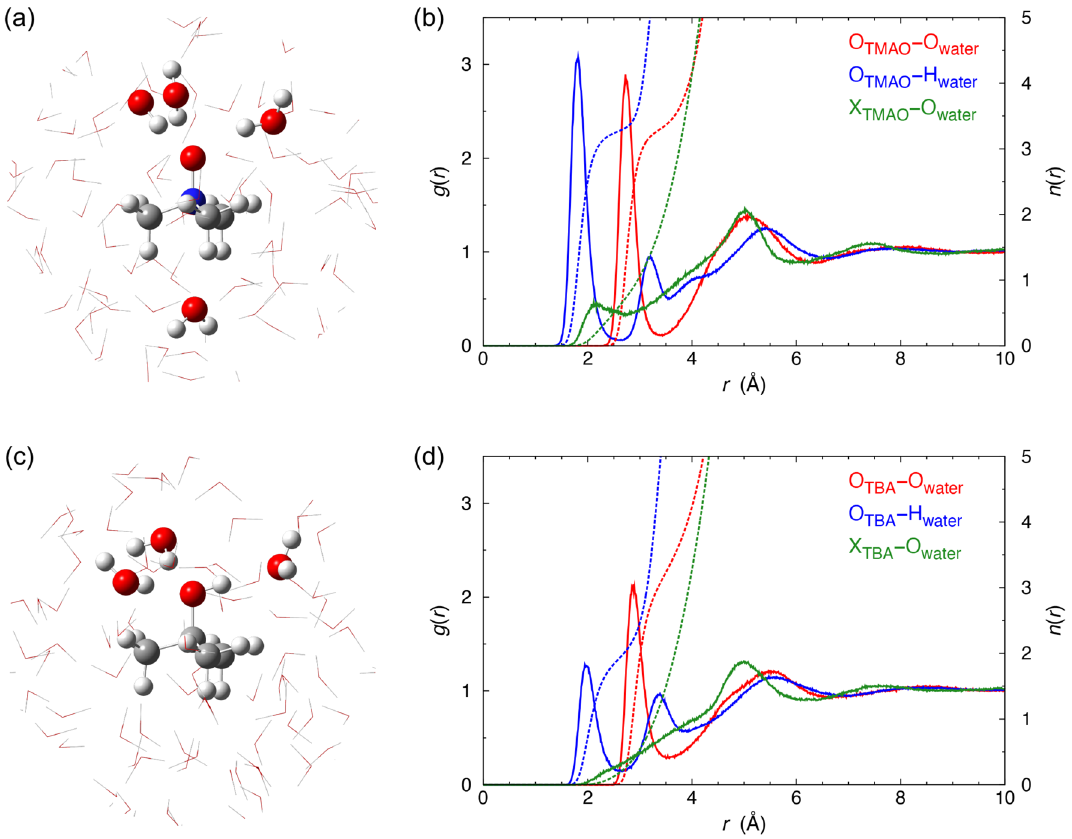
Figure 1. Solution structures simulated by EFP-MD. ( a ) Snapshot of aqueous TMAO. ( b ) Solute–solvent site RDFs, g ( r ), and hydration numbers, n ( r ), for aqueous TMAO. ( c ) Snapshot of aqueous TBA. ( d ) Solute–solvent site g ( r ) and n ( r ) for aqueous TBA. X TMAO/TBA was defined as the center of mass of the three axial hydrogen atoms of the CH 3 – groups in